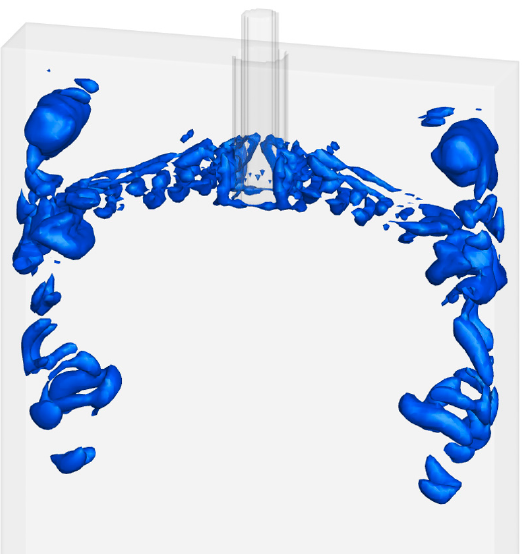
Figure 12. Vortex structures of the upper and lower streams near the wall of the mold formed using the Lambda-2 criterion λ 2 = 10.